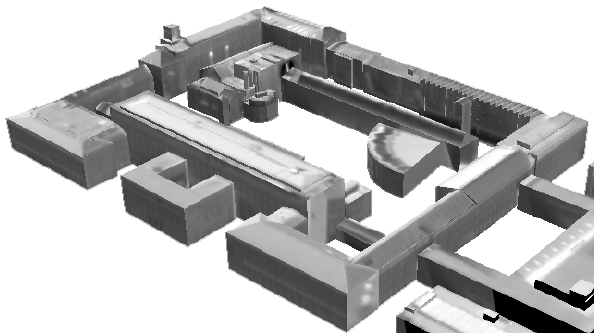
Figure 4: Calculation of matching quality The actual corresponding line can be measured in the image by a human operator, or it can be estimated using the intensity values surrounding the projected model line segment in the image. To